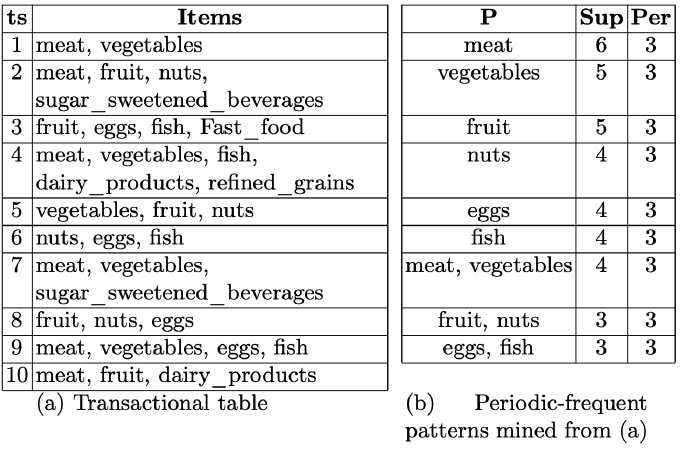
Figure 3. A toy example of periodic-frequent patterns